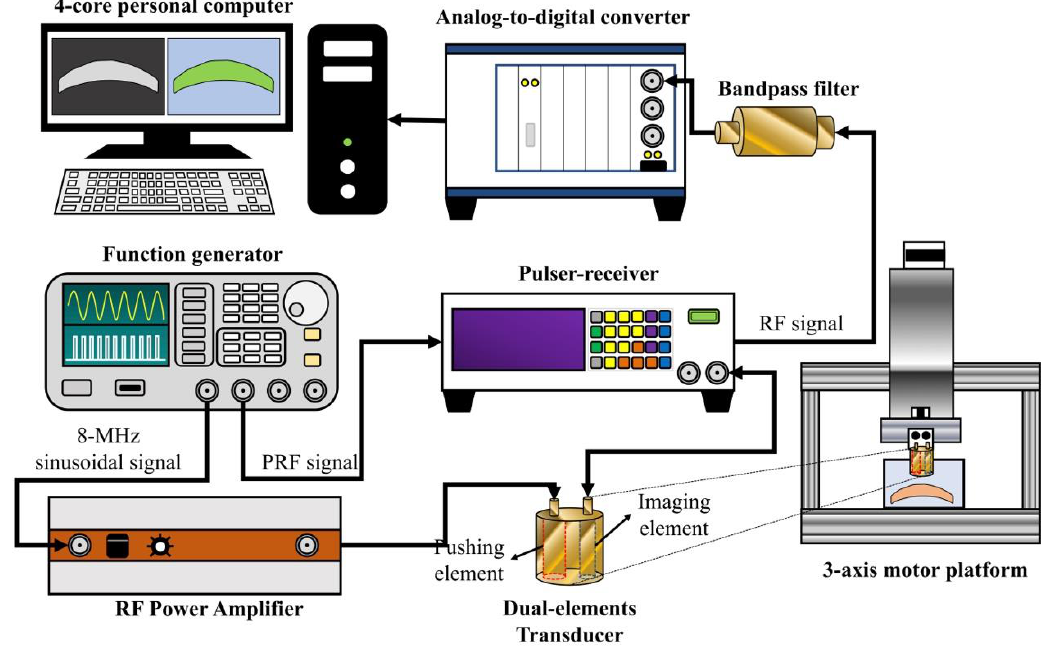
Figure 2. Experimental setup of the HR-SWI system. The function generator was used to generate the excitation signal for the pushing element and the trigger the imaging element. The 3-axis motor platform was used to move the dual-element transduce for measuring the GSWV at different locations.